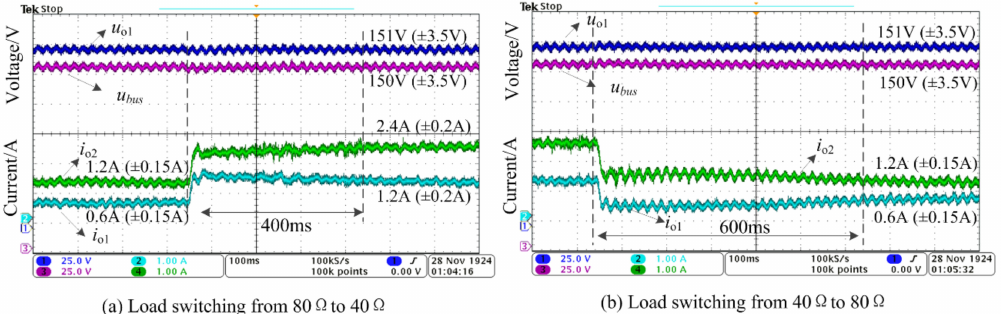
Figure 14. Experiment results of two parallel converters with unequal